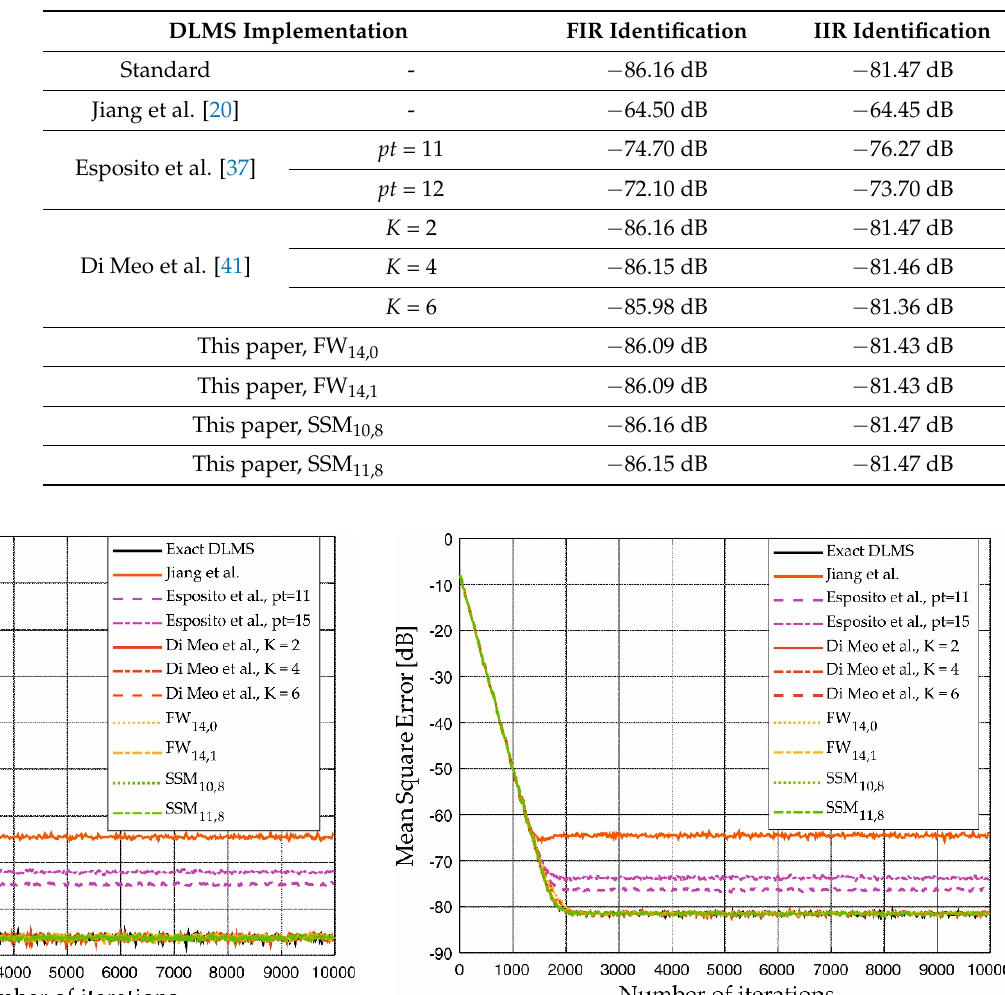
Table 1. Regime MSE of the proposed low-power implementations and of the state-of-the-art.